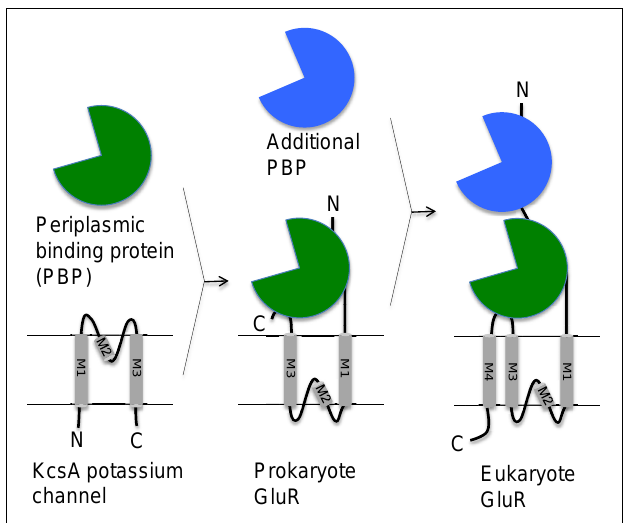
FIGURE 1 | Schematic representations of prokaryote and eukaryote glutamate receptors. The proposed origins of ligand binding domain (LBD, green) and amino terminal domain (ATD, blue), and the channel domain. Bacterial periplasmic binding protein and potassium channel are shown for comparison. Proposed gene fusion events that gave rise to the eukaryotic glutamate receptors are represented by arrows.